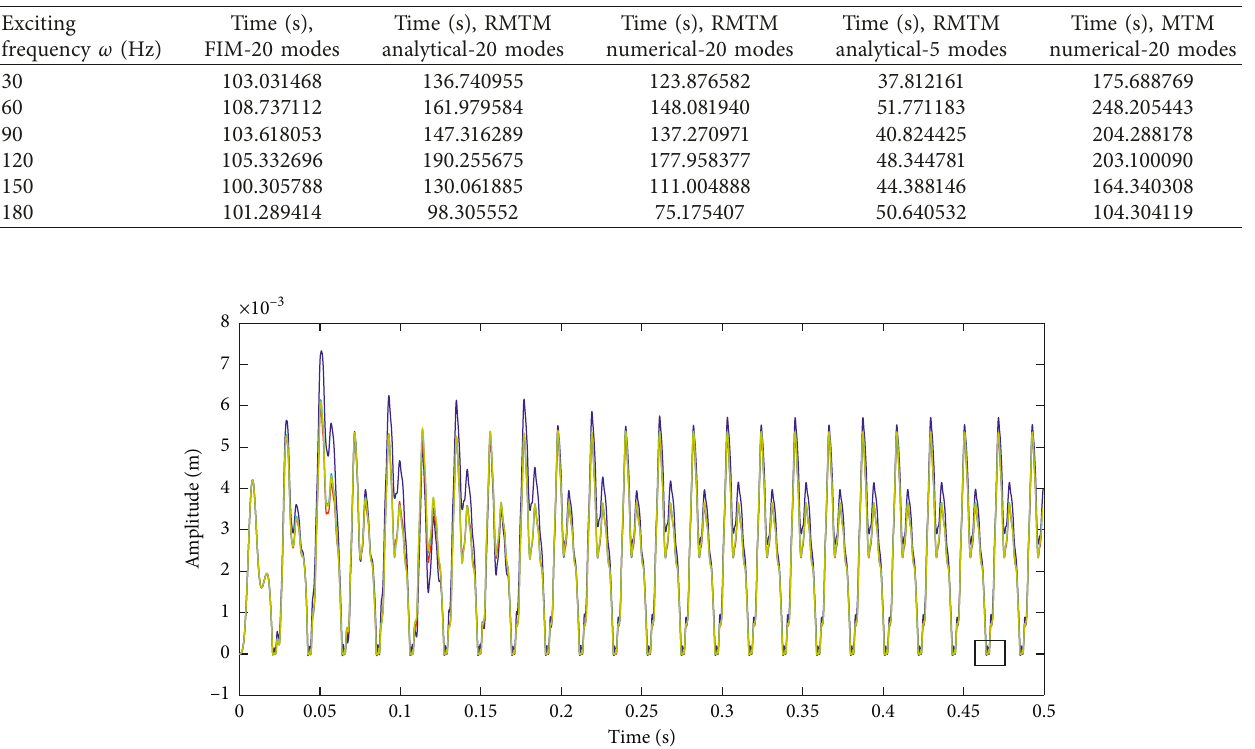
Table 3: Time consumption using different